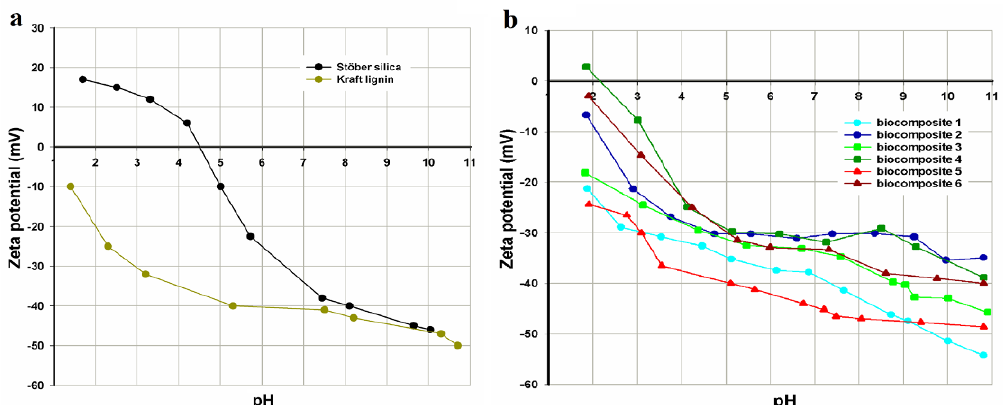
Figure 6. Zeta potential versus pH of (a) silica and Kraft lignin, and (b) silica/lignin biocomposites.